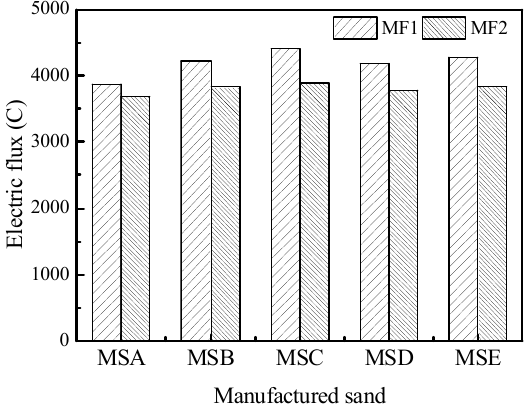
Figure 21. The coulomb electric flux of concrete with different manufactured sands.